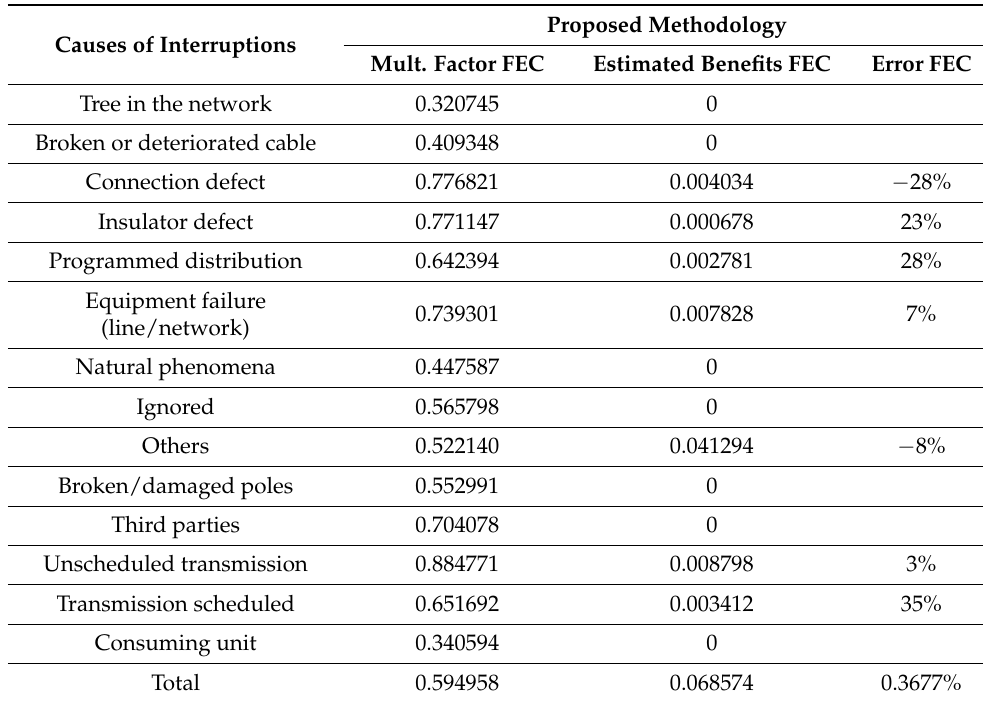
Table 7. Result of the FEC proposed